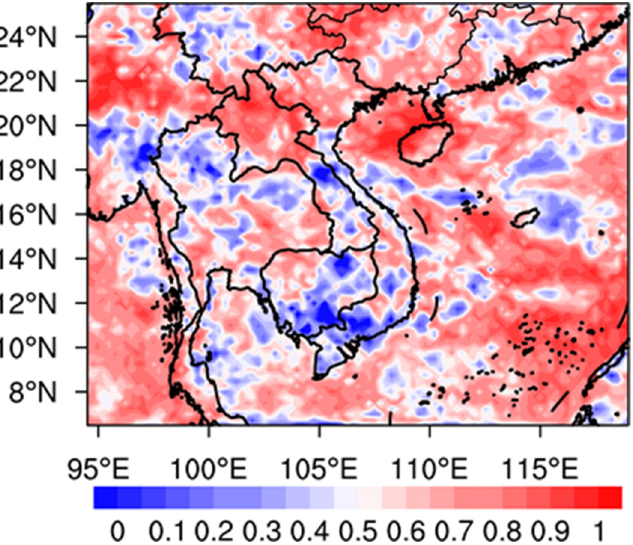
Figure 3. The correlation coefficients between time series of total daily precipitation of WRF simulations and ERA5 reanalysis data at each grid point from 17 August 2016 to 6 September 2016.